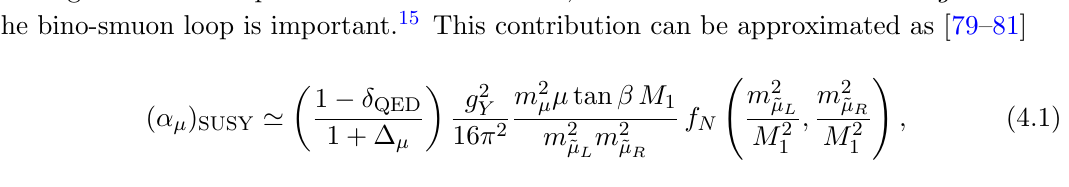
Figure 4 . Contours of the SUSY contribution to the muon g (cid:0) 2 for m m = 180 TeV (right). The geometric mean of the (cid:12)rst two generation squark masses [GeV] is 3 = 2 shown in black solid line. The gluino masses are (cid:25) 3 : 2 TeV (left) and (cid:25) 3 : 7 TeV